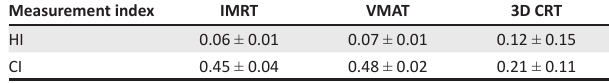
TABLE 4: Homogeneity index and conformity index.